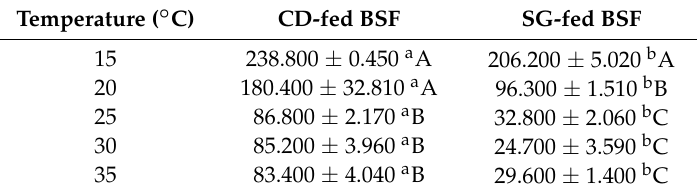
Table 1. Mean ( ± SD) duration of development (in days) of black soldier fly larvae reared on two different organic substrates at five different temperature regimes.